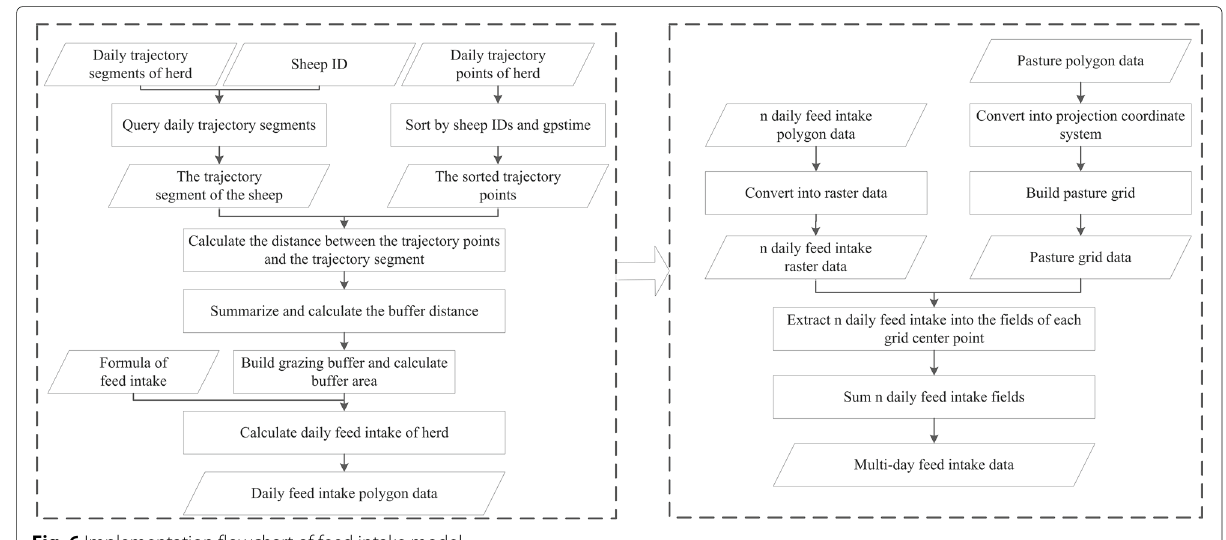
Fig. 6 Implementation flowchart of feed intake